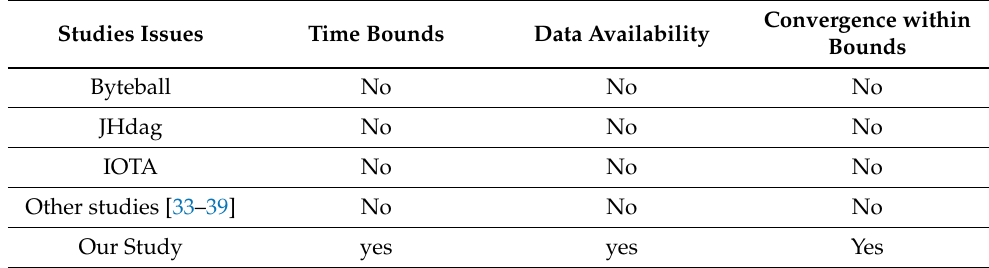
Table 2. Our results compared to the past studies. Offline functionality specifications are neither defined in DAG-based Bytebal, JHdag, and IOTA blockchains, nor in past studies and solutions that depend on IOTA’s offline blockchain